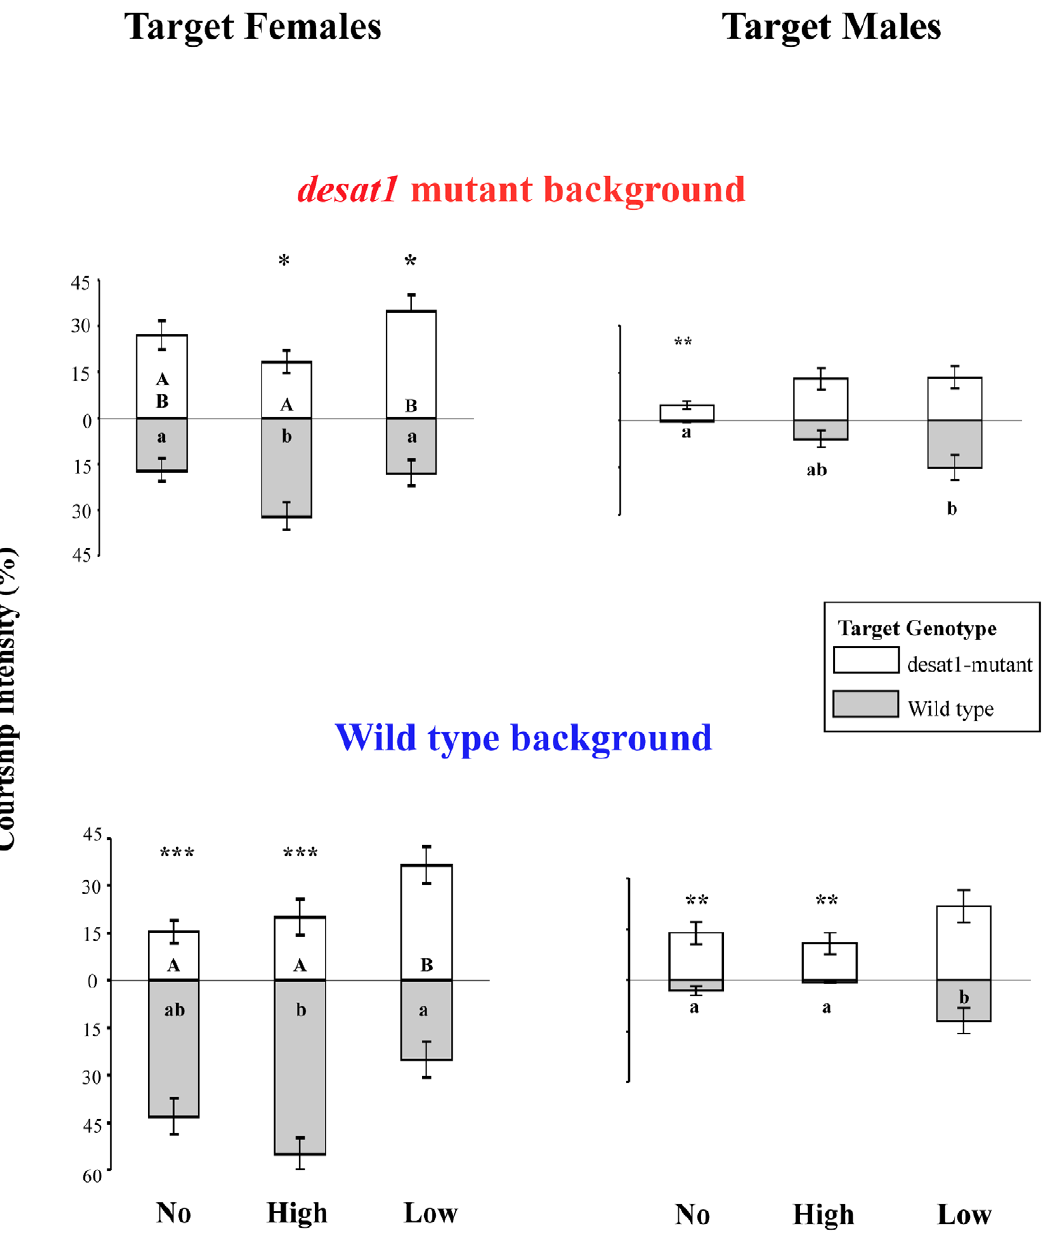
Figure 2. The selection process separately affects discrimination of female and male pheromones. At F20 and F21, males from the differently selected lines (No, High, Low) with the desat1 mutant (top) and wild-type backgrounds (bottom) were simultaneously presented to a pair of same-sex partner flies of desat1 (empty bars) and wild-type genotypes (filled bars). Mutant desat1 males and females produce a reduced level of sex pheromones compared to same-sex wild-type flies. Histograms represent the mean courtship index ( 6 sem) directed toward each target. The significance level of discrimination is indicated above each bar (t test). Different letters inside the bars (capital for desat1 target, lower case for wild- type target) indicate significant difference relatively to each target genotype (ANOVA with multiple pairwise comparaison and Bonferroni post-hoc tests). For all other information, please refer to Fig. 1. N $ 45.